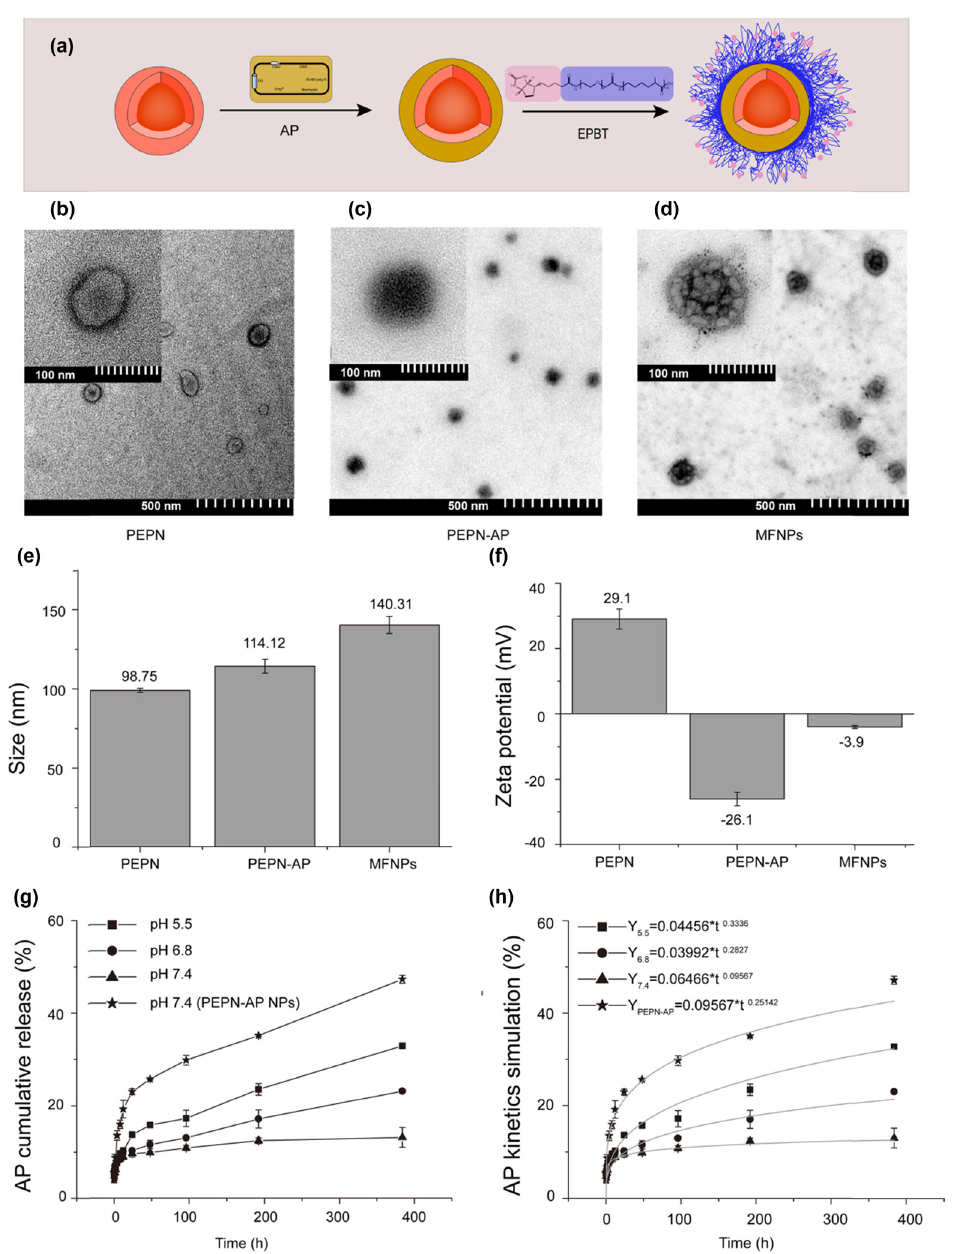
Figure 1: ( a ) The construction process of MFNPs, ( b ) TEM image of PEPN NPs, ( c ) TEM image of PEPN - AP NPs, ( d ) TEM image of MFNPs. ( e ) Particle size of PEPN NPs, PEPN - AP NPs, and MFNPs, ( f ) zeta potential of PEPN NPs, PEPN - AP NPs, and MFNPs, ( g ) cumulative release pro fi le of AP from MFNPs and PEPN - AP NPs at various pH, ( h ) kinetic simulation of AP cumulative release at various